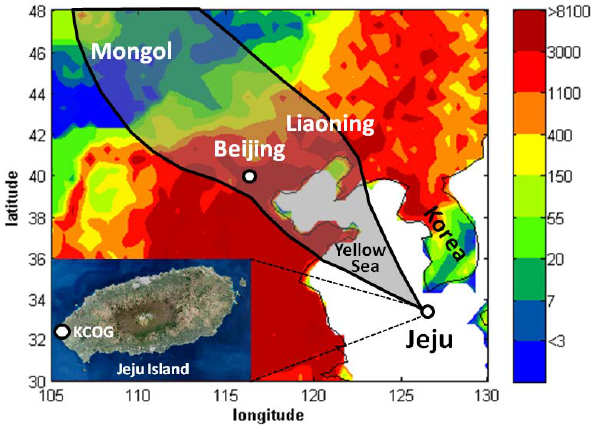
Fig. 1. Map depicting bottom-up emission inventory estimates of anthropogenic total organic carbon (TOC) estimated as the sum of black carbon (BC) and organic carbon (OC) in tons yr − 1 per 0.5 ◦ × 0.5 ◦ grid in year 2006 (Zhang et al., 2009). The five main ge- ographical source regions from back trajectories (BTs) analysis for the present March 2011 campaign (GoPoEx – Gosan Pollution Ex- periment) are indicated: Beijing, Liaoning, Mongol, Yellow Sea and Korea. The shaded sector between the black lines show the predom- inant range of BTs of the Chinese outflow for the study period. The location of the Korean Climate Observatory at Gosan (KCOG) on Jeju Island is shown in the inset satellite image, provided by NASA